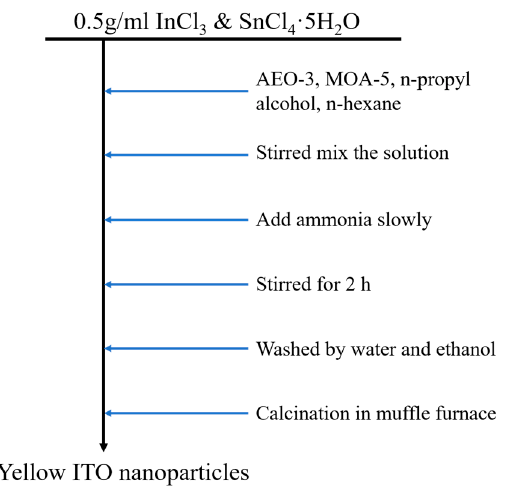
Figure 1. Flow chart of ITO nanoparticles prepared using the microemulsion method.